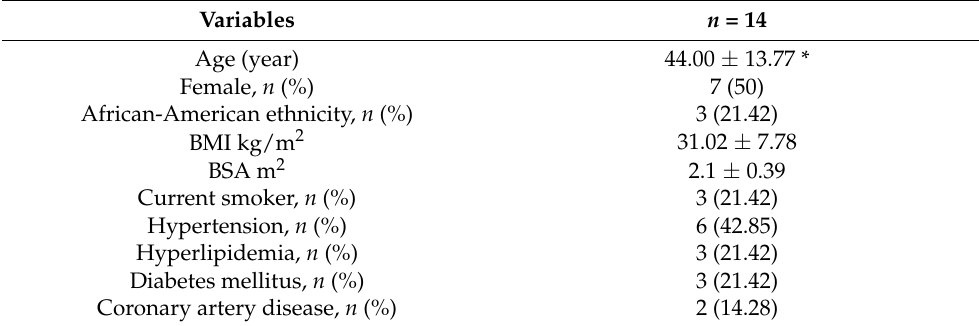
Table 1. Demographic and anamnestic characteristics of